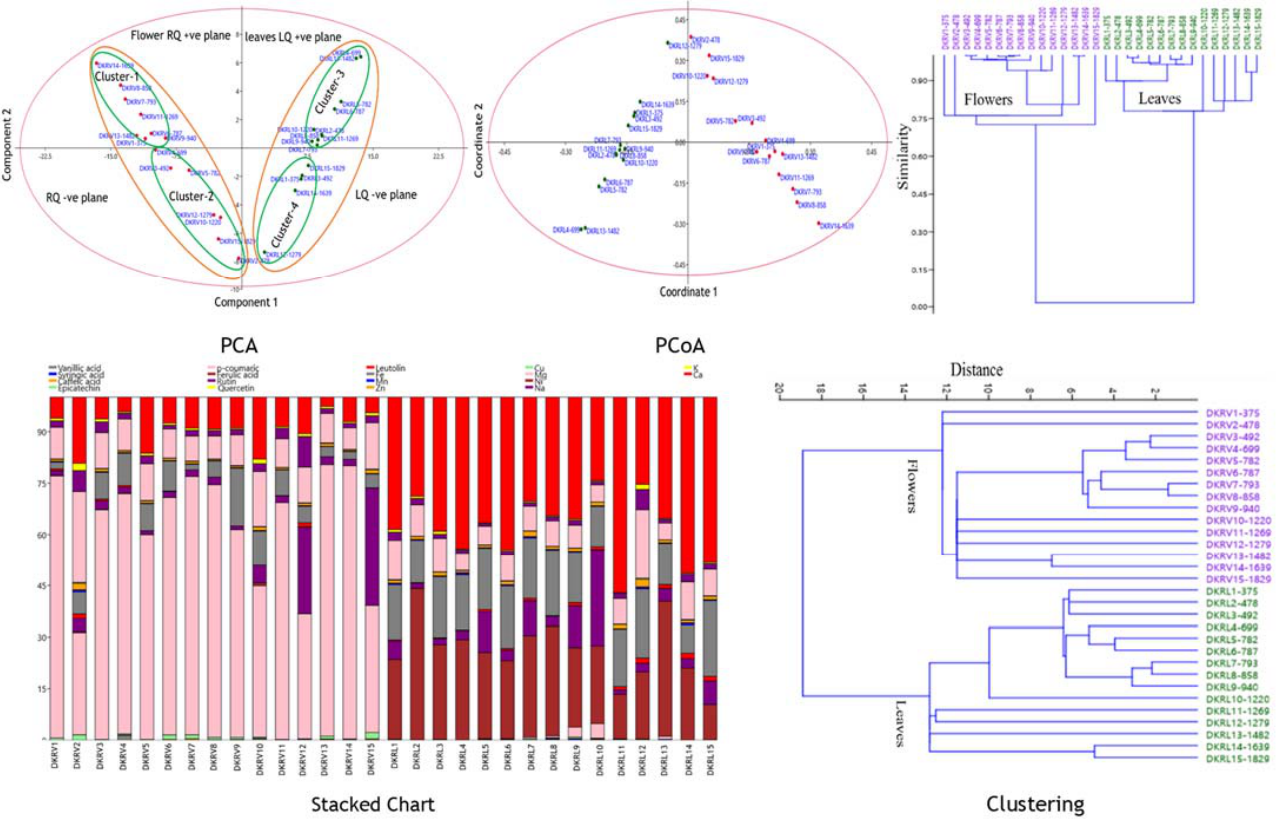
Figure 6. PCA, PCoA, stacked charts, and matrix plot of leaf and flower (TPC, TFC, UPLC- Polyphenols, and antioxidant activity) at gradient altitude. PCA: principal component analysis; PCoA: principal coordinate analysis; HCA: hierarchical clustering analysis. DKRV1 to DKRV15: flowers samples; DKRL1to DKRL15: leaves samples.